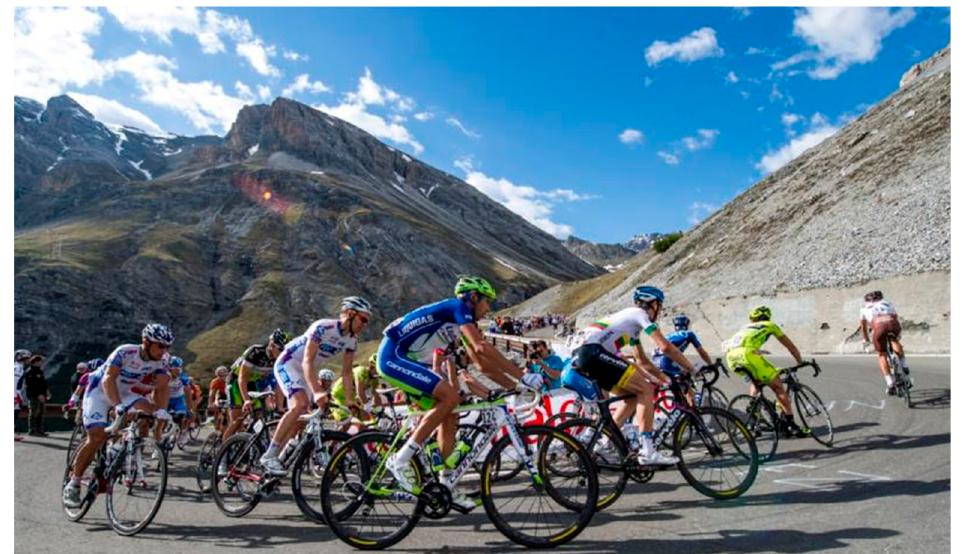
Figure 2. Dolomitic stage Giro d’Italia 2013: WHS, a great territorial resource. The stages in the North East of Italy are strongly representative of the dual Risk/Resource characterizing the Italian country: so beautiful, so fragile.